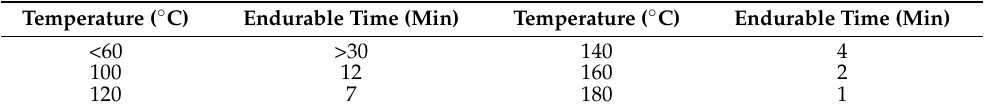
Table 1. Survival times that the human body can withstand at different